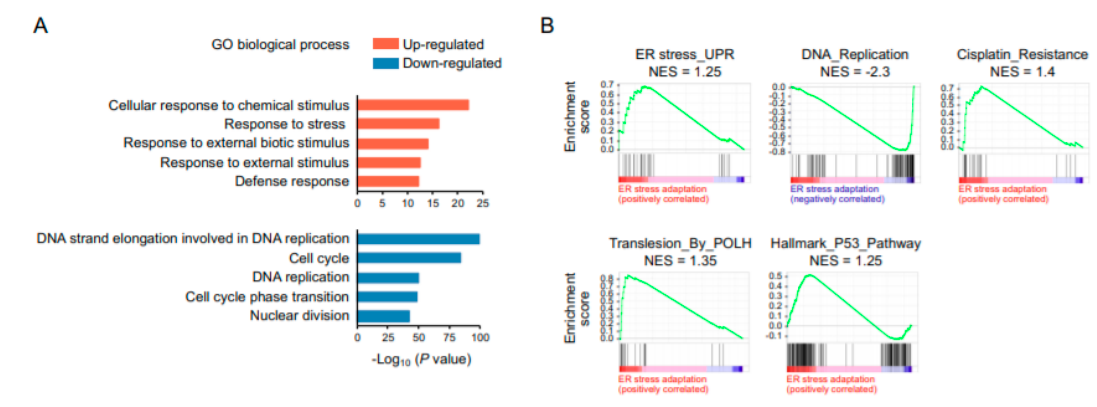
Figure 4. RNA sequencing analysis reveals a global suppression of DNA replication and cell-cycle progression in ER stress- adaptive cells. ( A ) Gene ontology analysis of biological processes that are enriched in up-regulated and down-regulated genes. ( B ) Gene Set Enrichment Analysis (GSEA) of over-represented and under-represented gene sets. NES, normalized enrichment score.